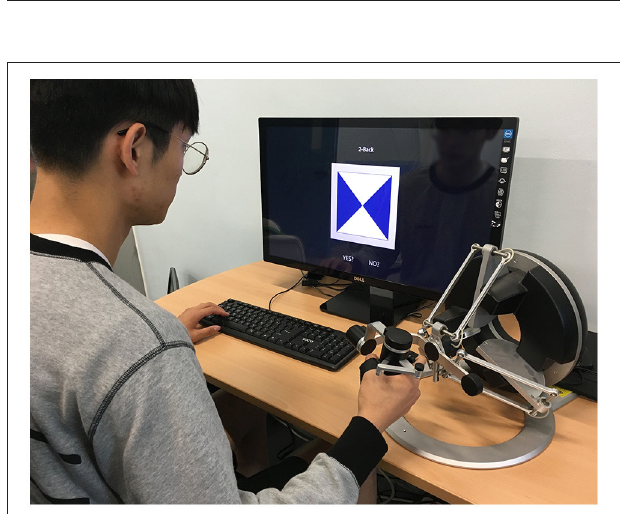
FIGURE 2 | Experimental setup with a haptic device and a